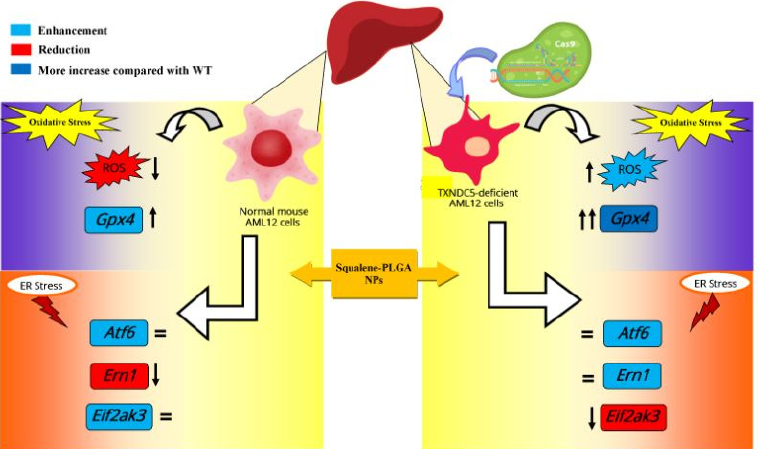
Figure 9. Scheme showing the effects of squalene on cells involved in oxidative and ER stress in the presence and absence of TXNDC5. In presence of squalene, wild-type and TXNDC5 deficient AML12 cell lines were exposed to oxidative and ER stress. The scheme reveals that in absence of TXNDC5, ROS abundance and Gpx4 mRNA expression are enhanced, and Eif2ak3 expression is decreased; whereas, in presence of TXNDC5, the ROS amount and Ern1 mRNA level are reduced. This scheme was designed using Microsoft Publisher Document version 2010. ↑ Increased, ↓ Decreased